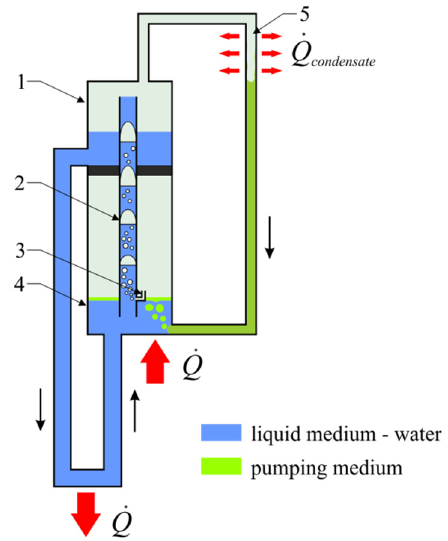
Figure 7. Circuit diagram of a reverse thermosiphon with two working media: 1—separator, 2—vapor lift pump, 3—steam inlet, 4—evaporator, 5—thermal receiver,